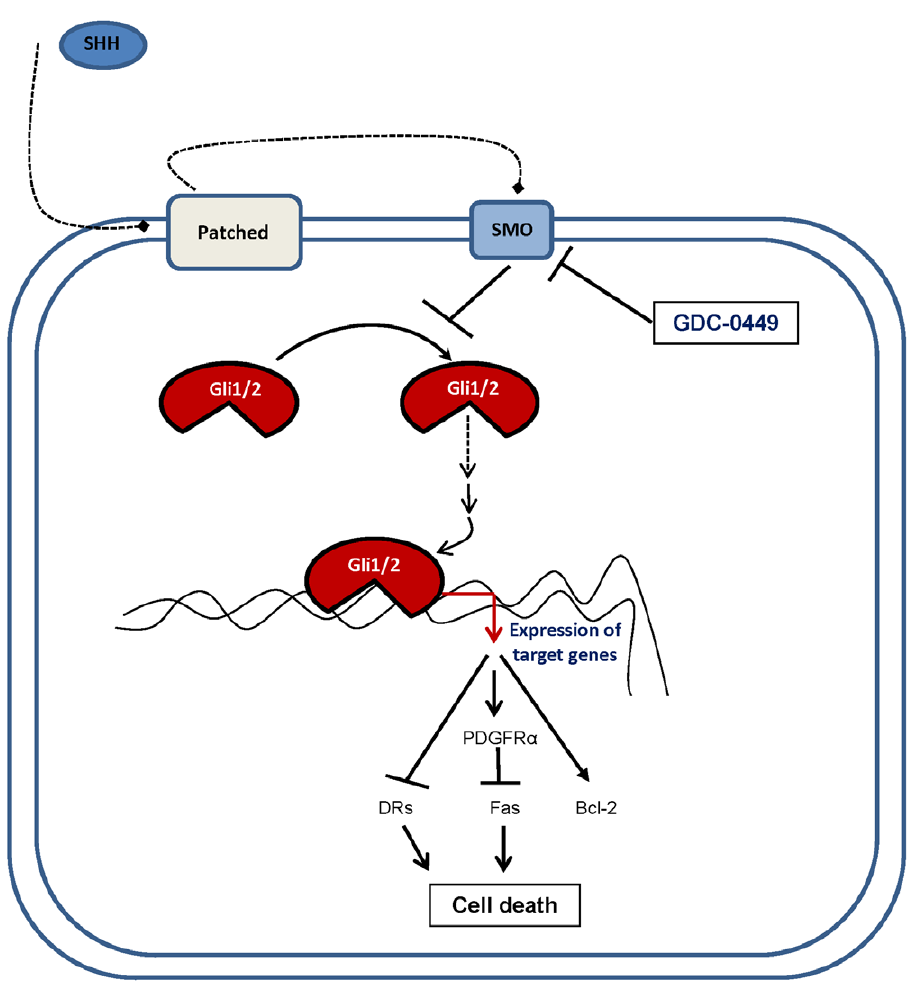
Figure 7. Schematic representation of the inhibition of SHH signaling and genes involved in the balance between cellular proliferation and cell death. Activated Gli1 and Gli2, downstream of SHH-Patched-Smoothened, regulate targets of SHH signaling including Bcl-2, PDGFR a , Fas, and DRs. GDC-0449 (targeting Smoothened) blocks the indirect functions of Gli activators, resulting in cell death.